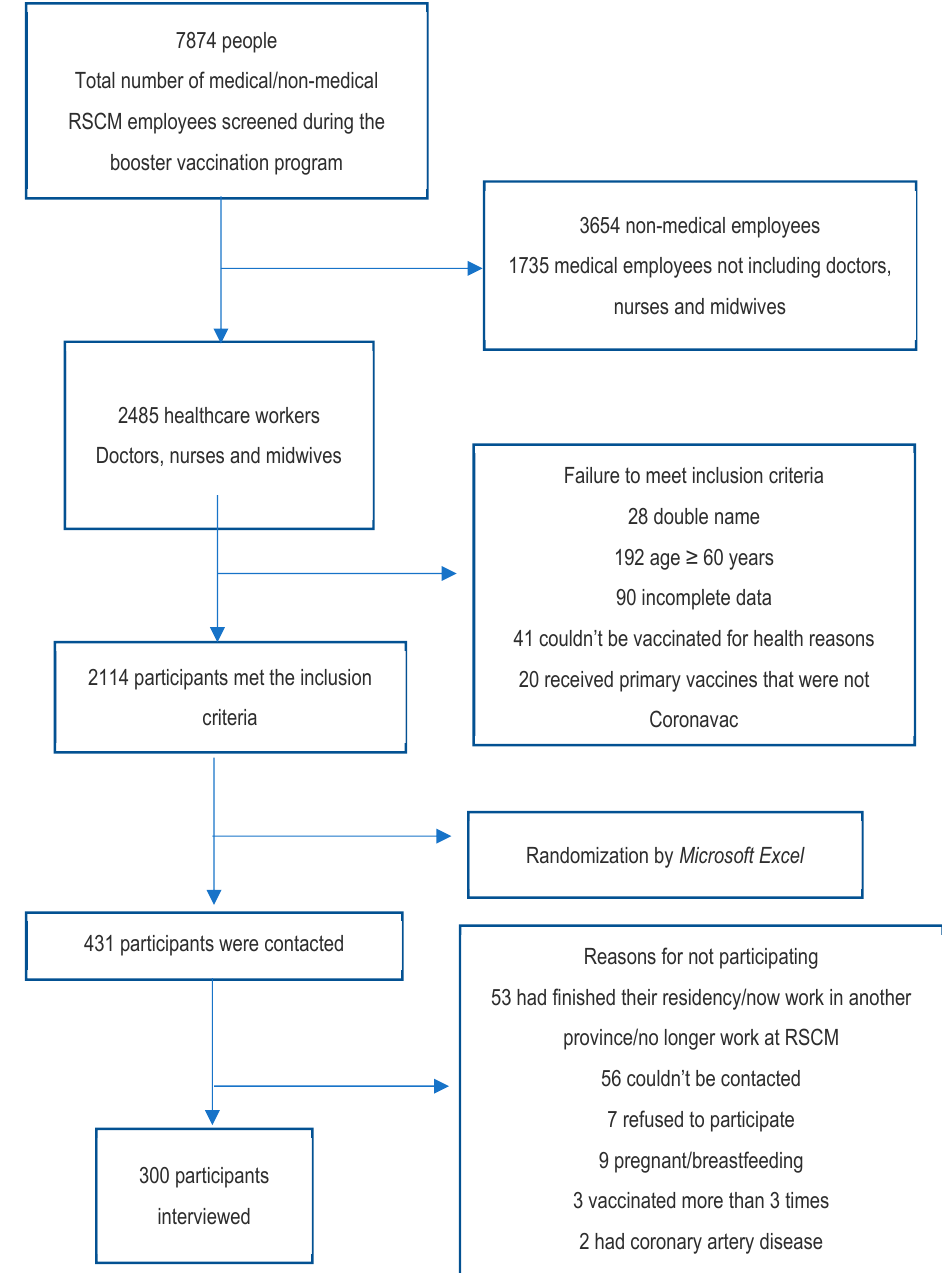
Figure 1. Flow of participant recruitment. In sum, 7874 RSCM employees with either medical or nonmedical backgrounds received the mRNA-1273 booster vaccination and had been recorded in the screening data of the COVID-19 booster program. From these 7874, 300 participants were obtained and